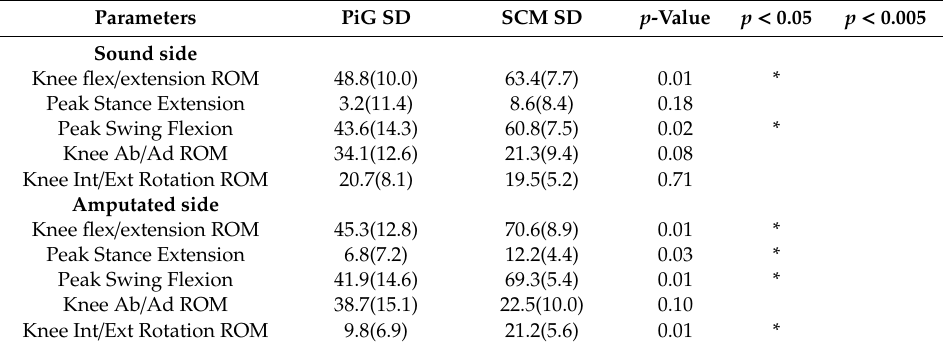
Table 8. Knee joint angle parameters of 7 amputee participants on sound and amputated side as mean SD over three gait cycles calculated by the PiG and